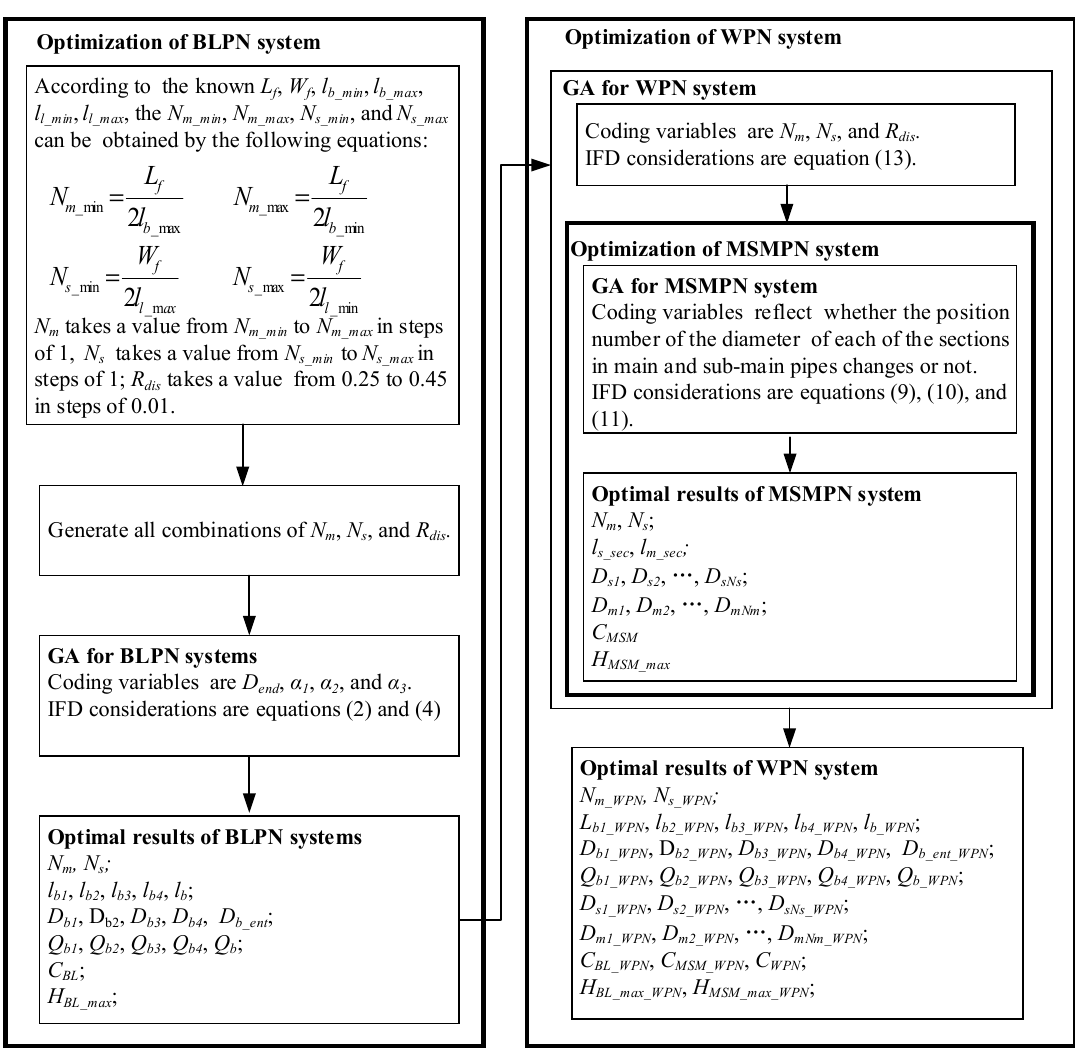
Figure 4. Flowchart of the optimization.